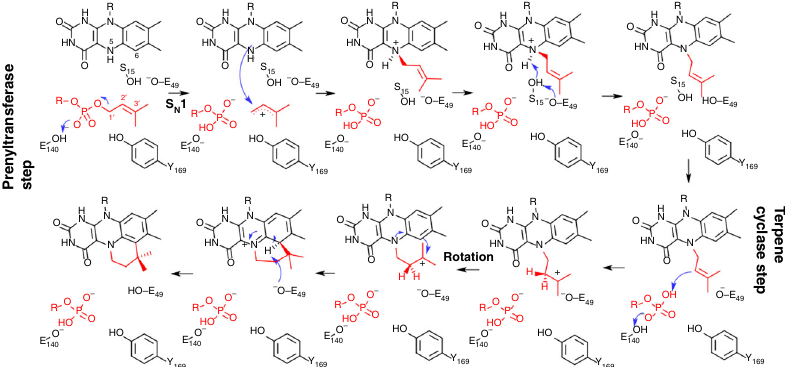
Fig. 6 A detailed mechanism for UbiX. The prFMNH 2 formation in UbiX occurs through sequential formation of two FMN – dimethylallyl linkages, the N5 – C1 ′ and C6 – C3 ′ bonds. The N5-prenylation resembles other unrelated prenyltransferases, requiring the dimethylallyl moiety to allow formation of a resonance stabilised carbocation via an S N 1 mechanism using either DMAP or DMAPP as substrate. Flavin reduction is key to initiation of the N5 – C1 ′ bond-formation step. Following the prenyltranserase step, the Friedel – Crafts alkylation of the fl avin C6 is initiated by proton transfer via the bound (pyro)phosphate, requiring the presence of the conserved E49 to allow formation of the prFMNH 2 product by proton abstraction from C6